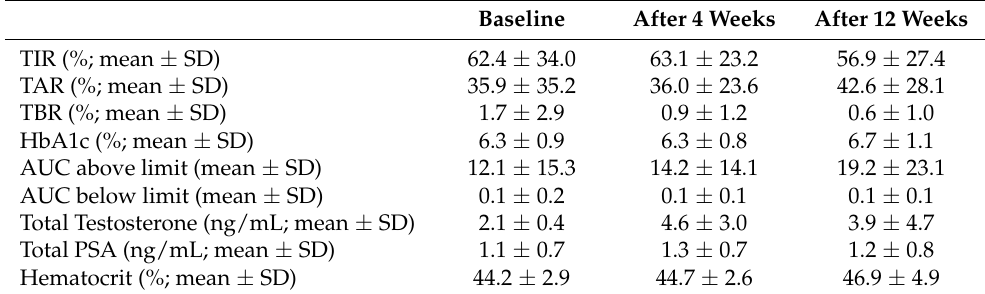
Table 2. Time in range (TIR), time above range (TAR), time below range (TBR), estimated HbA1c, AUC above and AUC below limit, total testosterone, total prostate-specific antigen (PSA), and hematocrit at baseline time and after 4 and weeks of testosterone replacement